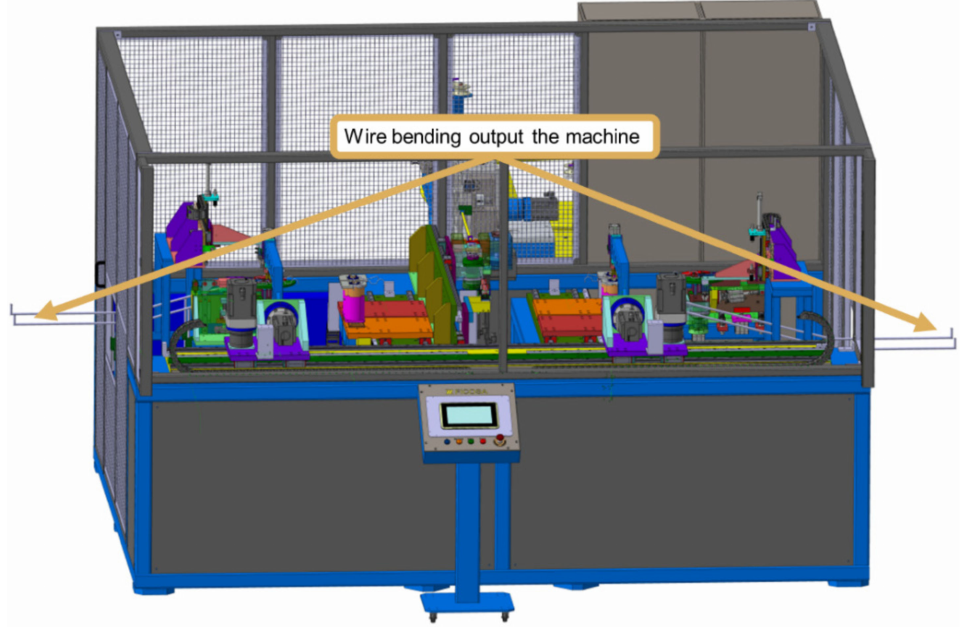
Figure 23. Wire-bending output